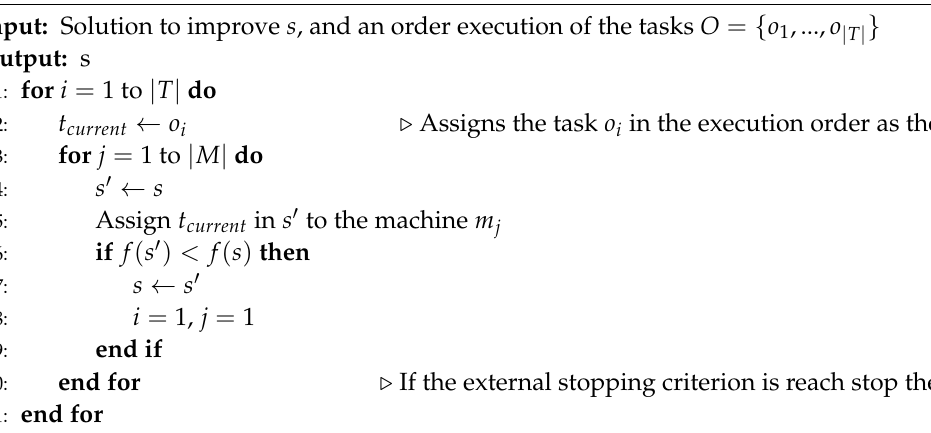
Algorithm 6 EFT-ILS Local Search